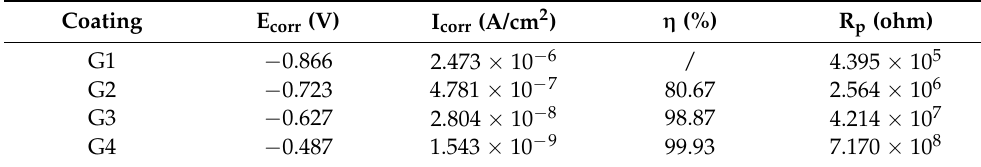
Figure 16. Each EP/CeO 2 -GO coating’s Tafel curve for 60 days: ( a ) 20% Seawater; ( b ) 40% Seawater; ( c ) 60% Seawater. Table 6. Kinetic parameters of each coating in seawater of 20% concentration for 90 days.